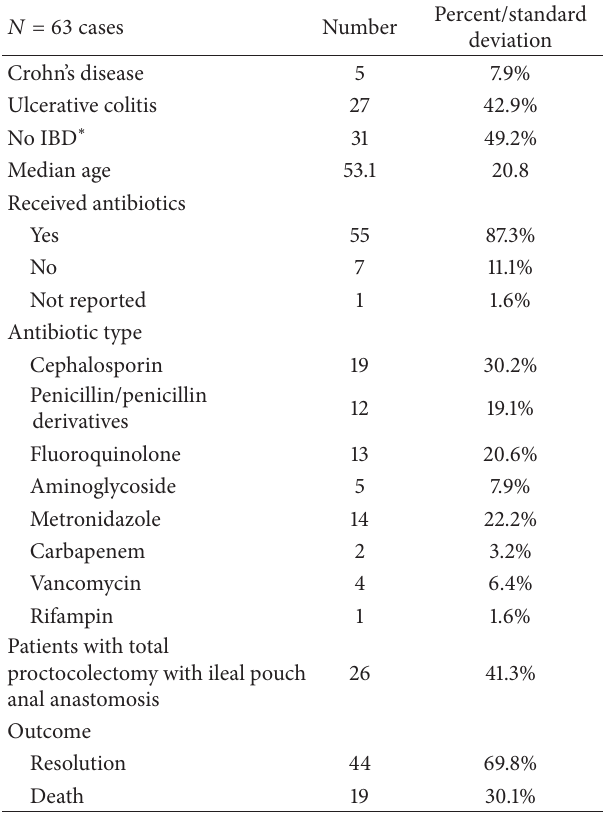
Table 1: Demographic features, risk factors, and outcomes of reviewed case reports. ∗ IBD = inflammatory bowel